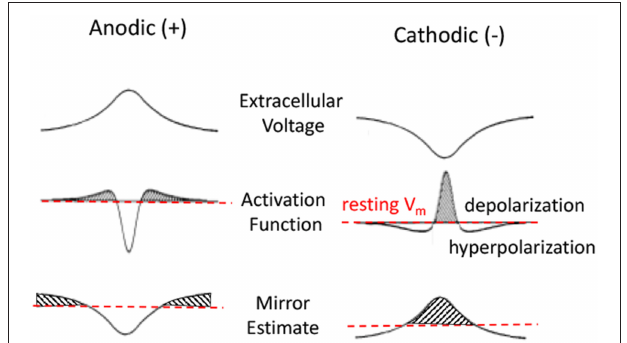
FIGURE 4 | Anodic and cathodic stimulation model approximations. Top row is the extracellular voltage distribution along the fiber. Second and third rows are Activating Function (AF) and Mirror Estimate (ME) approximations of the resulting membrane potential changes. Anodic stimulation delivers a hyperpolarizing center, with short depolarized (shaded) side lobes. Cathodic stimulation delivers a strong depolarization near the electrode and hyperpolarization at the side lobes. The Activation Function is more accurate for short pulses. The Mirror Estimate is more accurate for long duration